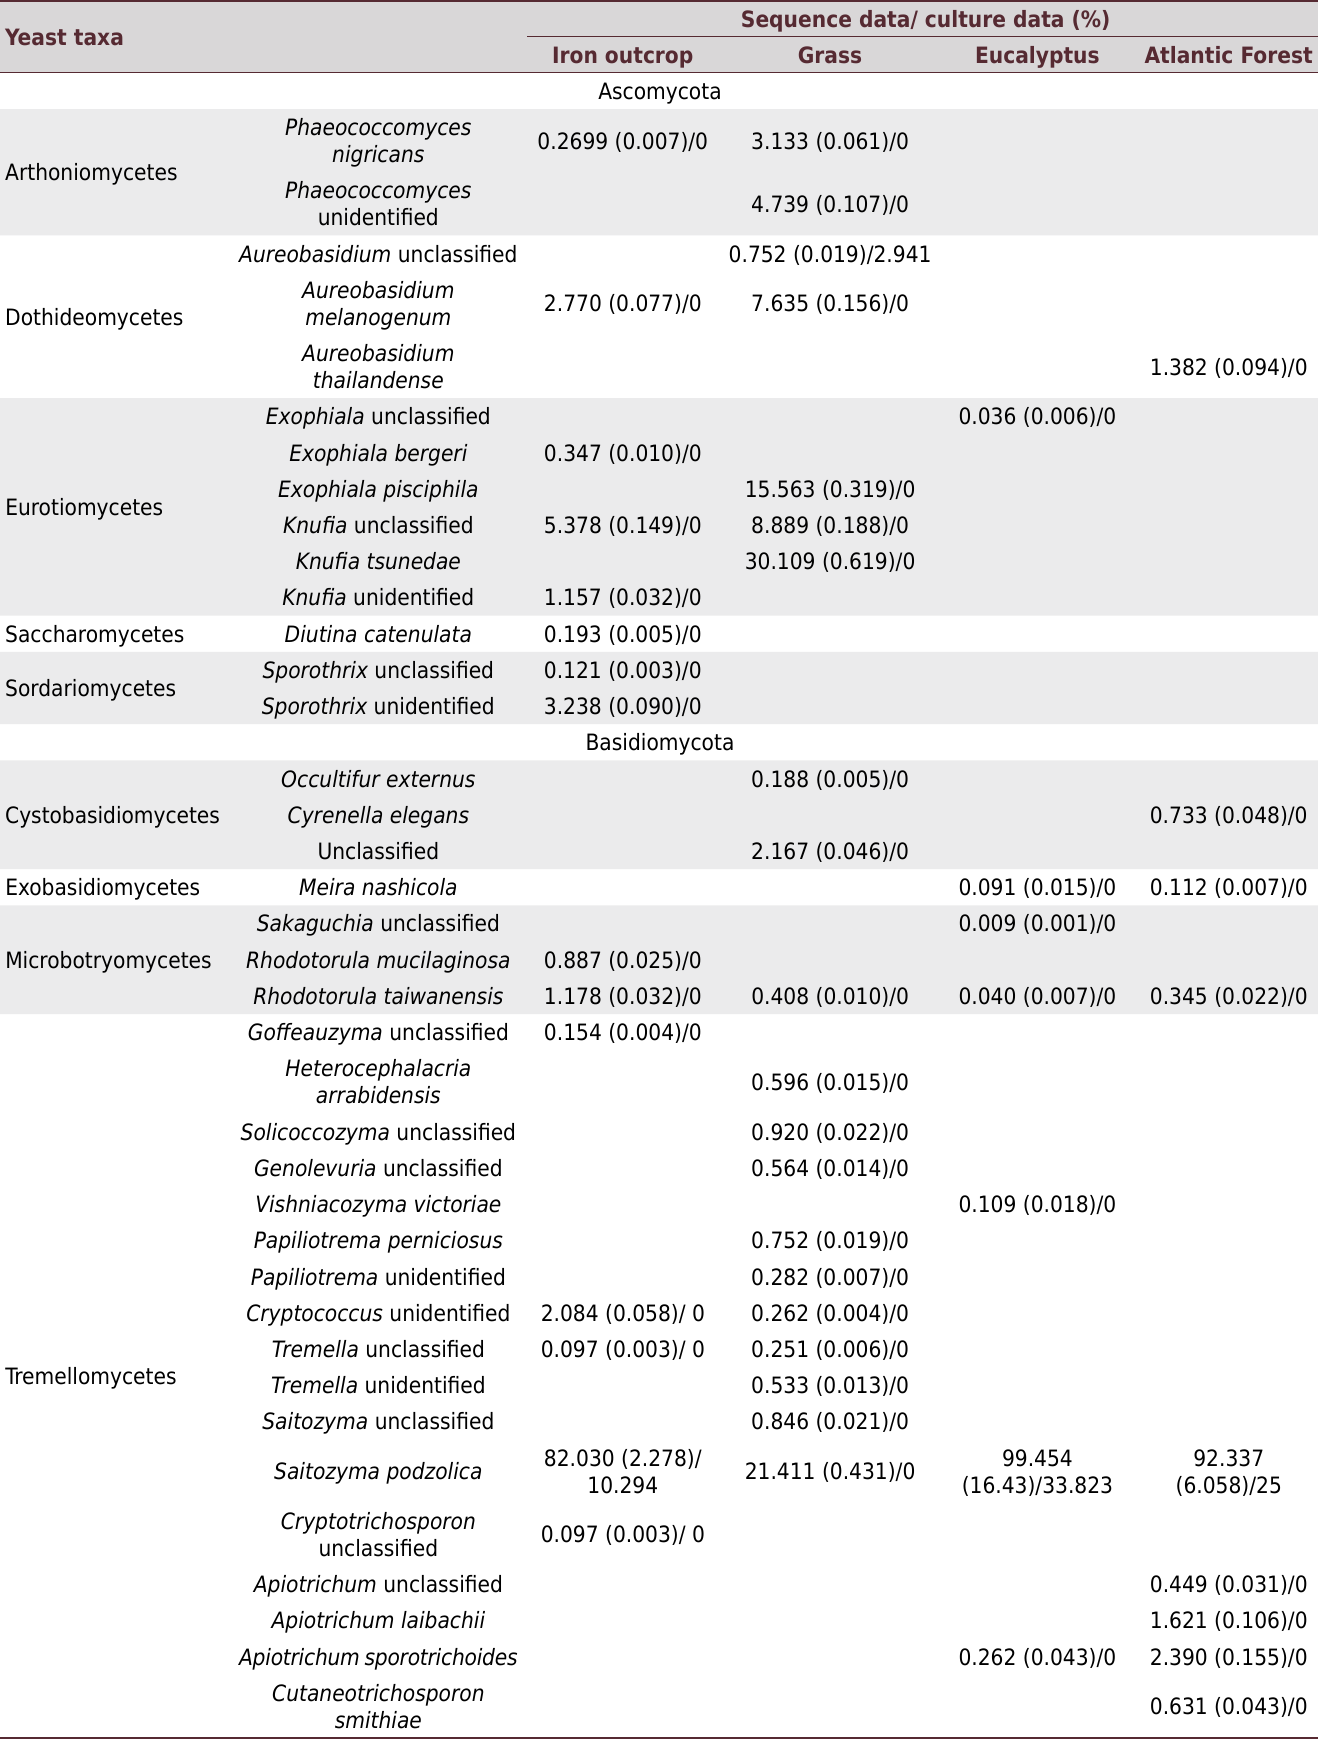
Table 2. Average relative abundance (%) of yeast species and genera by site: comparison between sequence data/culture data. Relative abundance of each taxon by the total fungi for sequence data is expressed within parenthesis Yeast